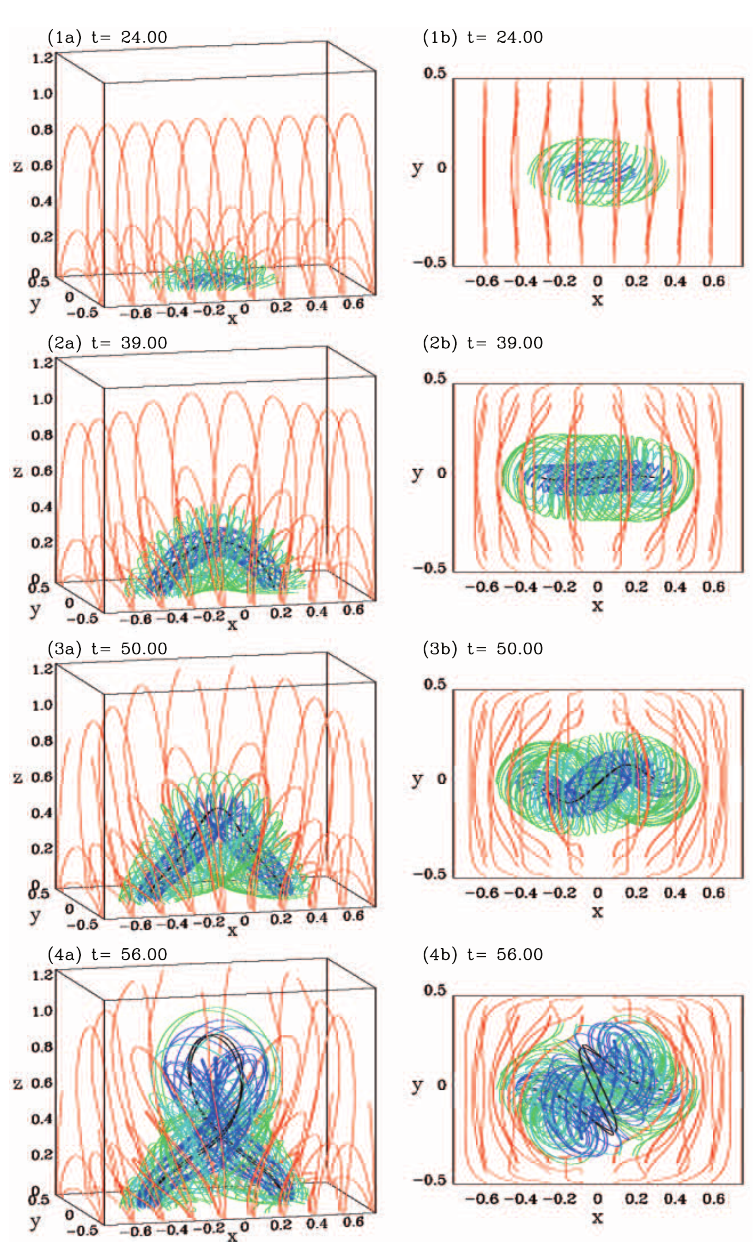
Figure 59: Snapshots of the field lines of the 3D simulation by Fan and Gibson (2004) as viewed from the side (left panels) and the top (right panels). Image reproduced with permission, copyright by